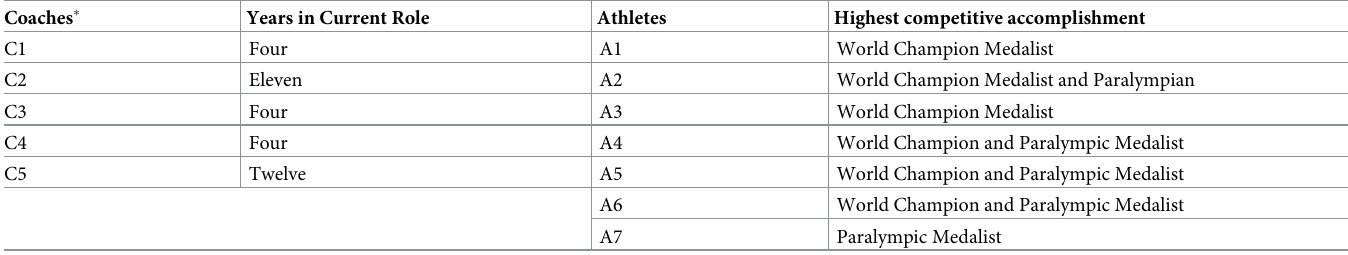
Table 1. Details for each participant in the